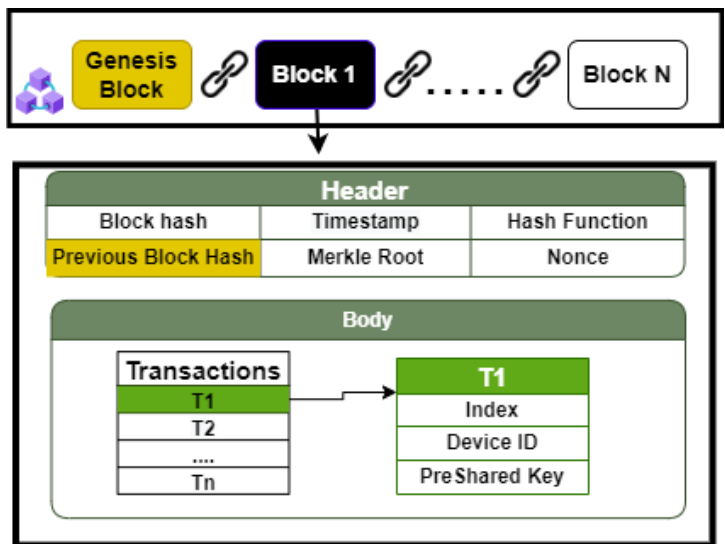
Figure 4 . Blockchain block structure . Figure 4. Blockchain block